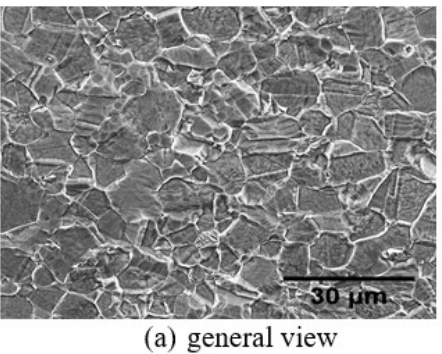
Figure 1. Microstructure of Inconel 718 superalloy as received.